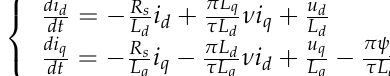
In the above formula, R S is the stator resistance; τ is the PMLSM polar distance; v is the running speed of the linear motor; u d and u q is the voltage of the shaft; i d , i q is the current of the shaft; L d , L q is the inductance component of the shaft; ψ f is the